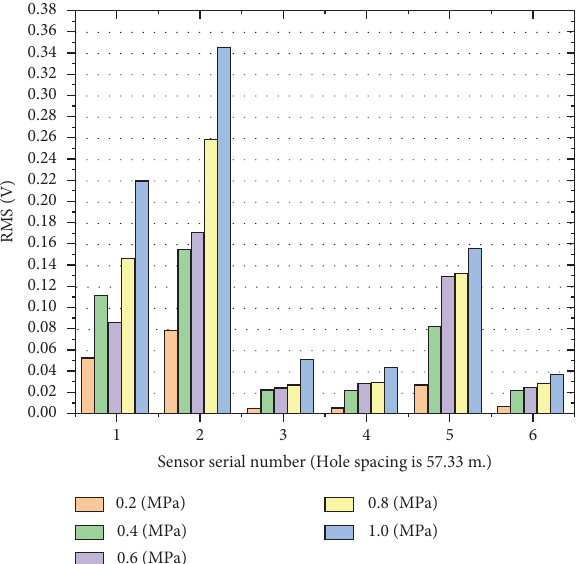
Figure 11: Variation of the attenuation coefcient along the downstream of A and B leakage under diferent pressures.